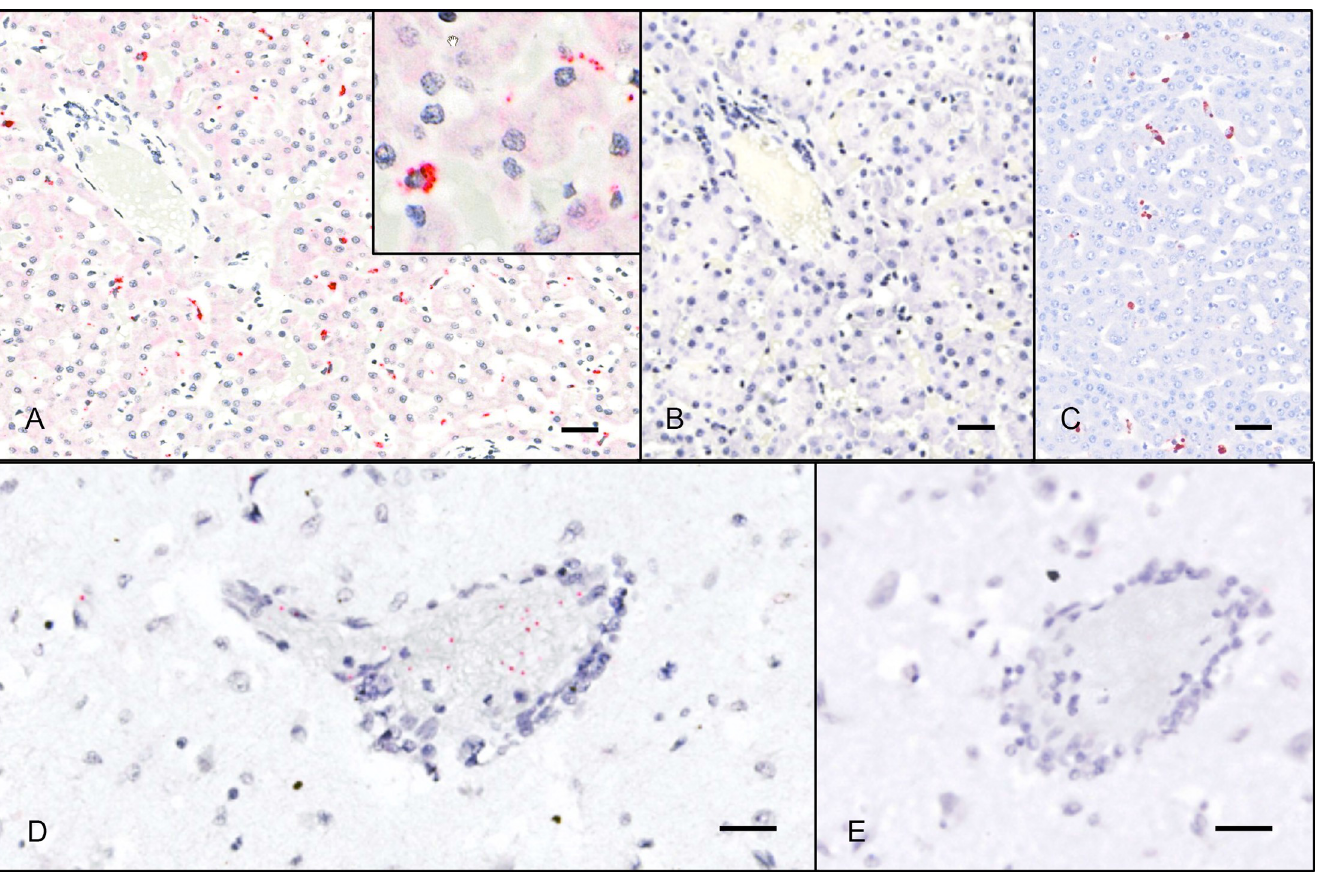
Fig 3. ISH detection of UaCV nucleic acid in tissue sections. Case 1. UaCV probes (A, D) and negative control (DapB) probes (B, E); hematoxylin counterstain. A. In sections of liver, UaCV ISH signal is detected in scattered polygonal cells (presumed Kupffer cells or endothelial cells) in hepatic sinusoids. Inset: higher magnification of a cell exhibiting positive probe hybridization. B. No signal is detected with negative control (DapB) probes. C. Immunohistochemistry for PCV2 in the liver of a pig demonstrates a similar pattern of immunoreactivity. (UC Davis SVM archives. IHC performed at California Animal Health and Food Safety Laboratory, Davis CA.) D. Sections of brain exhibit punctate UaCV ISH signal in and around small-caliber blood vessels. E. No signal is detected with negative control probes. Bars = 25 μ